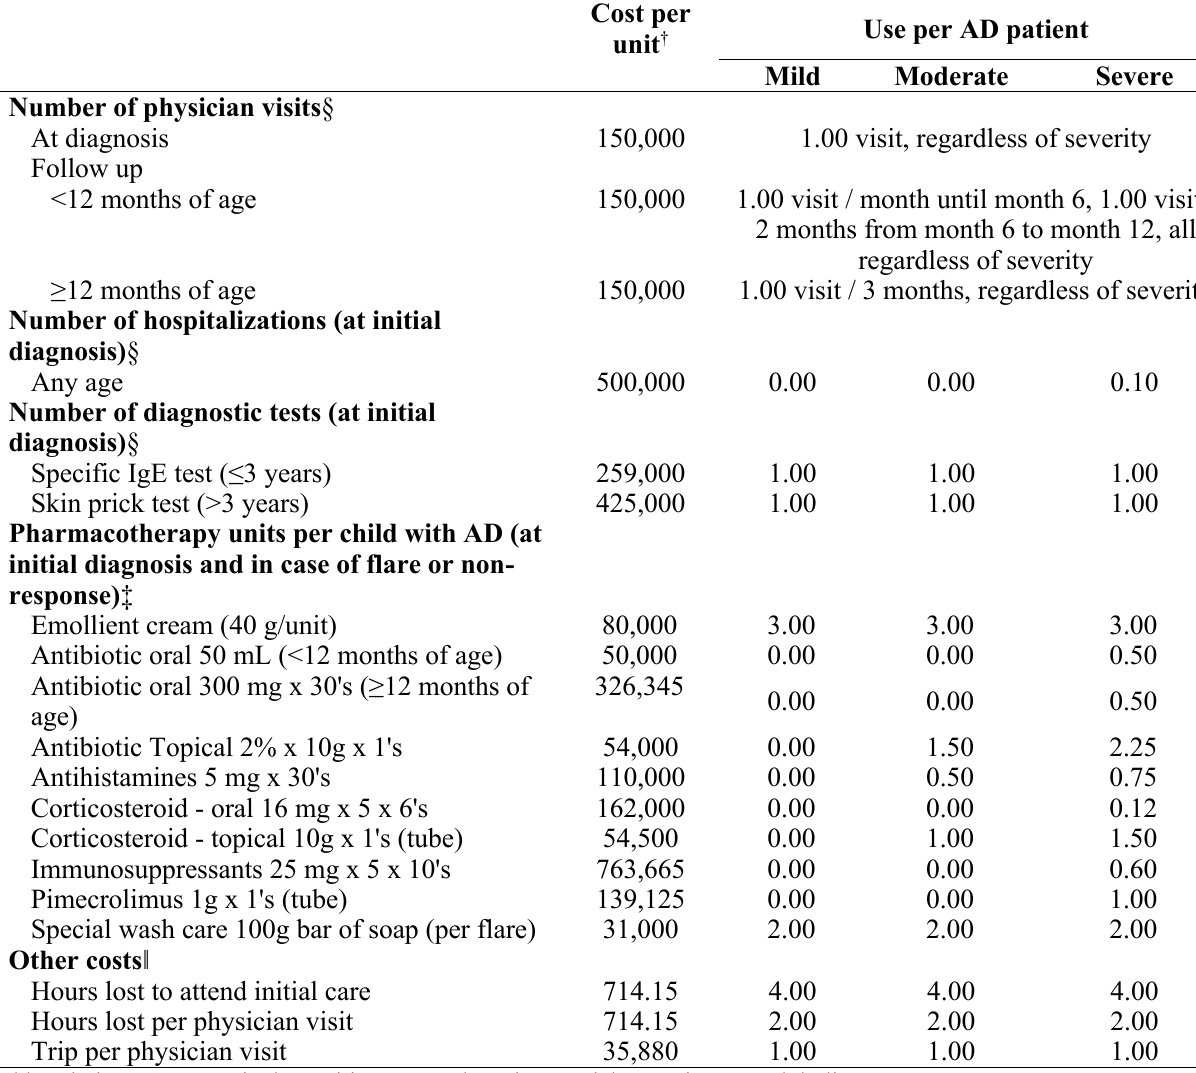
Table 3. Price and Quantities of Resources Used Treat AD by Severity at